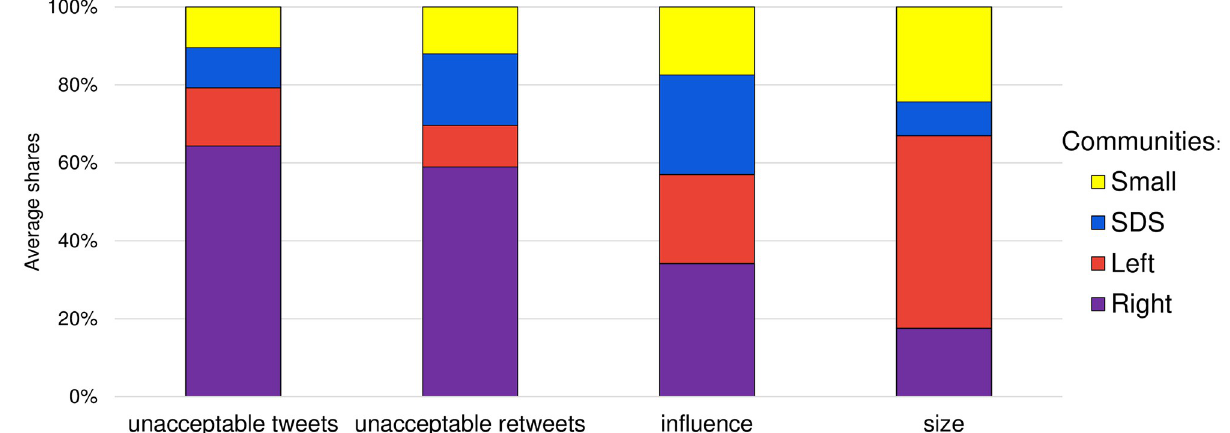
Fig 5. Comparison of the three major communities in terms of four different properties. Each bar is composed of the Right, Left, SDS, and the remaining Small communities, from bottom to top. Bars correspond to the average shares (over the five weekly timepoints) of posted unacceptable tweets, retweeted unacceptable tweets, community influence (weighted out-degree), and size of the community, from left-to-right, respectively.